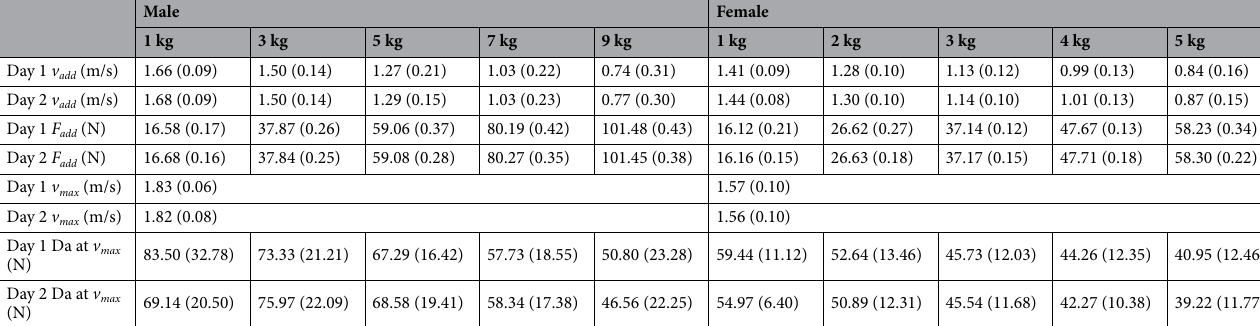
Table 1. Mean (standard deviation) of the variables related to the active drag calculation. v add , mean swimming velocity with an additional resistance; F add , mean additional resistive force due to the external load; v max , estimated maximum velocity in a free-swimming condition; D a , active drag.